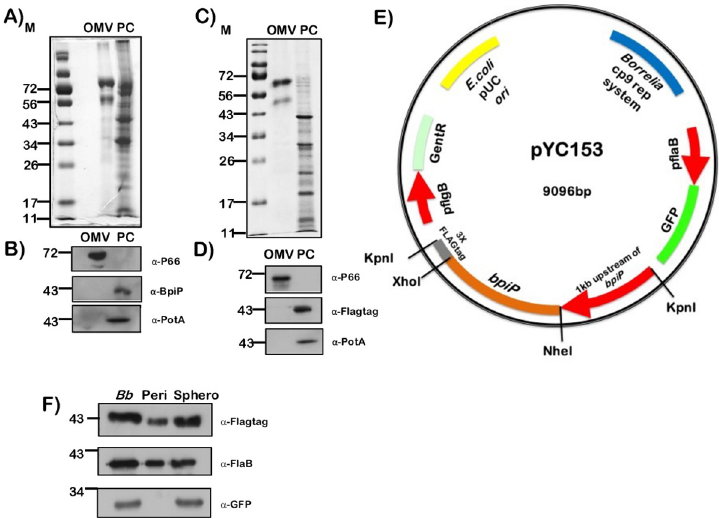
Fig 2. Cellular Localization of BpiP. Fractionation of ( A ) Bb wild type strain B31- A3 and ( C ) bpiP mutant expressing Flag-tagged BpiP, in trans , transformed with E ) plasmid pYC153. pYC153 was derived from pTM61 that constitutively express green fluorescent protein (GFP) under the control of the P flaB promoter. The construct also carries determinants for replication in both E . coli and B . burgdorferi , gentamicin resistance ( aacC1 ) cassette, upstream regions of bpiP and bpiP fused to 3x- FLAG tag. Spirochetes were fractionated into outer membrane vesicle (OMV) and protoplasmic cylinder (PC) fractions as described in the Materials and Methods section. Fractions were separated on 12% SDS-PAGE gel stained with Coomassie brilliant blue ( A, C ) or transferred to PVDF membranes and subjected immunoblot analysis ( B, D ) using specific antisera indicated to the right of each blot. (F). Periplasmic and spheroplasmic fractions were separated on SDS-PAGE, transferred to PVDF membrane as described in the Materials and Methods section and subjected to immunoblot analysis with anti-FLAG tag, anti-Green Fluorescent Protein (gfp) or anti-FlaB antibodies. Blots were developed using goat-anti-mouse or anti-rabbit IgG conjugated with HRPO as secondary antibody and Enhanced Chemiluminescence. Lanes 1) Outer membrane vesicle fraction (OMV) 2) Periplasmic cylinder (PC). Note detection of BpiP or BpiP-FLAG only in the PC fraction using either anti-BpiP or anti-FLAG antibody. P66 localized to OMV and PotA to PC fraction in both wild type and bpiP mutant complemented with pYC153. Molecular masses in kDa are indicated to the